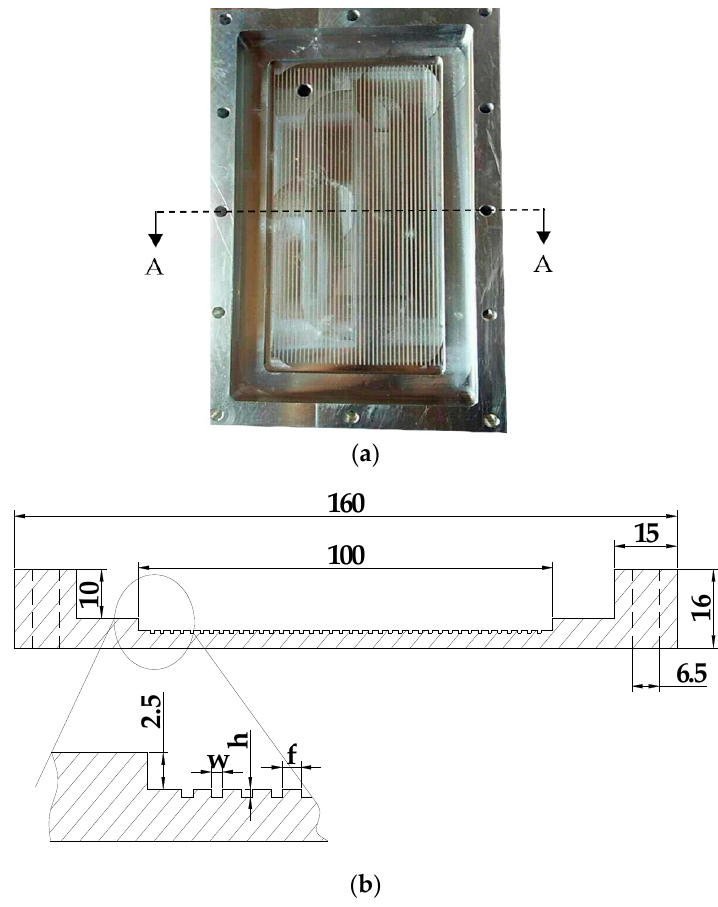
Figure 1. ( a ) A photo of a fabricated flat micro-grooved gravity heat pipe (FMGHP); ( b ) The A–A cross-section of the micro-grooves in a FMGHP (units: mm).